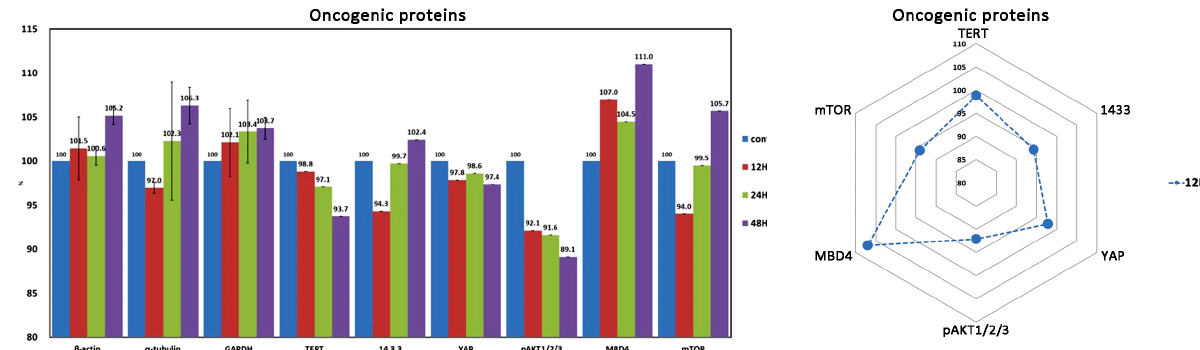
Figure 7. Changes to oncogenic proteins after PTX treatment in RAW 264.7 cells. Left-sided graph shows changes to protein expressions according to the application time of PTX, blue bar; control group, red bar; 12 h treatment of PTX, green bar; 24 h treatment of PTX, purple bar; 48 h treatment of PTX. Right-sided polygonal graph shows protein expression profiles after 12 h treatment of PTX. (JPG 342